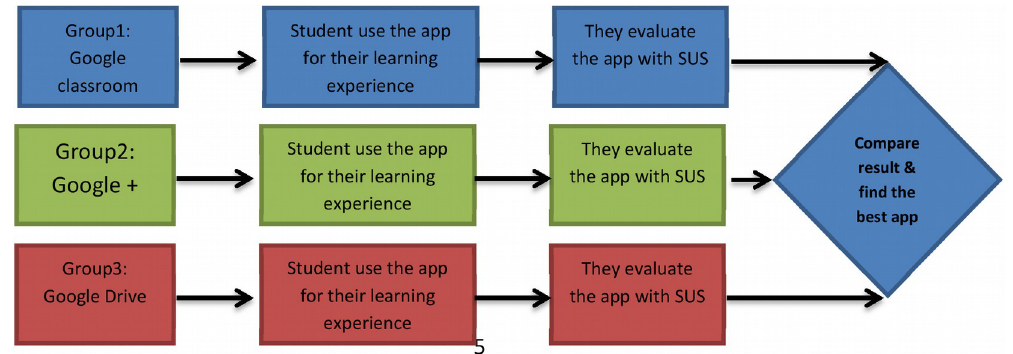
Figure 1. Usability testing process